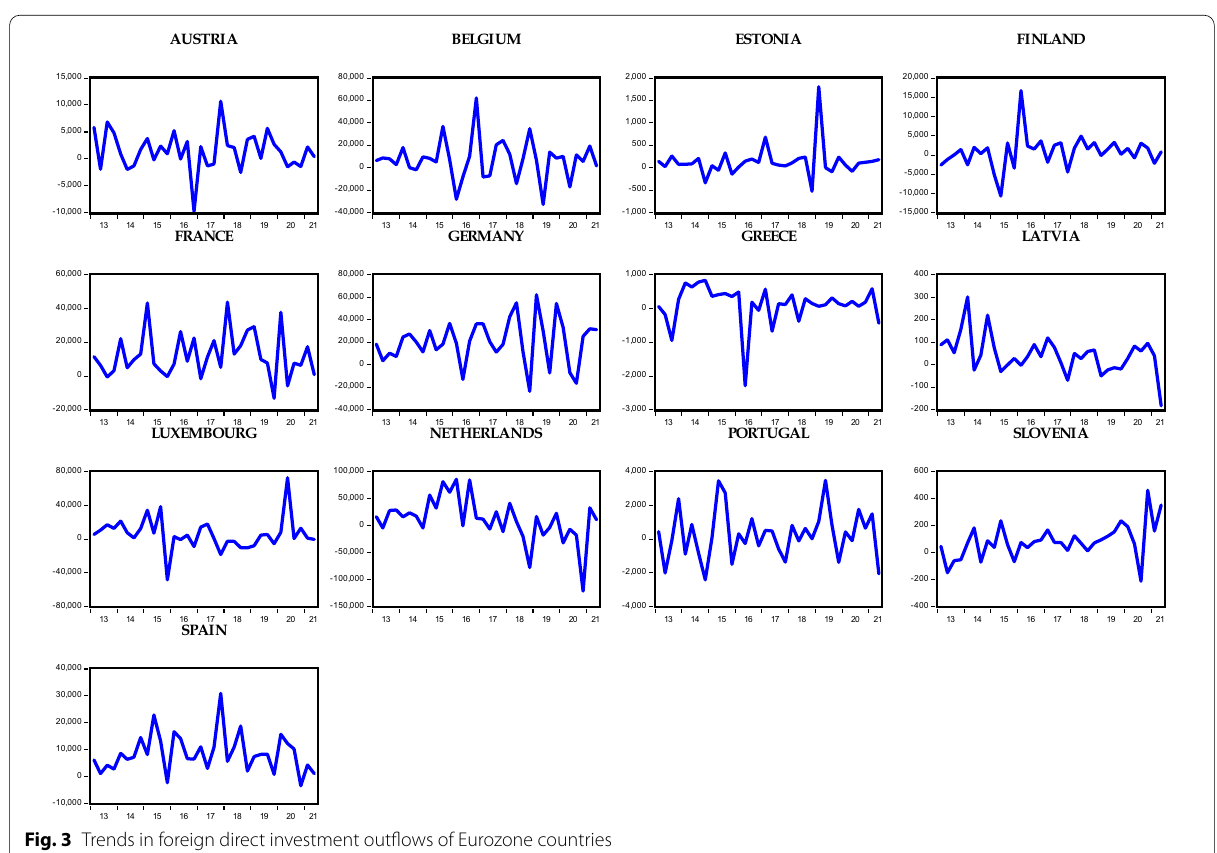
Fig. 3 Trends in foreign direct investment outflows of Eurozone